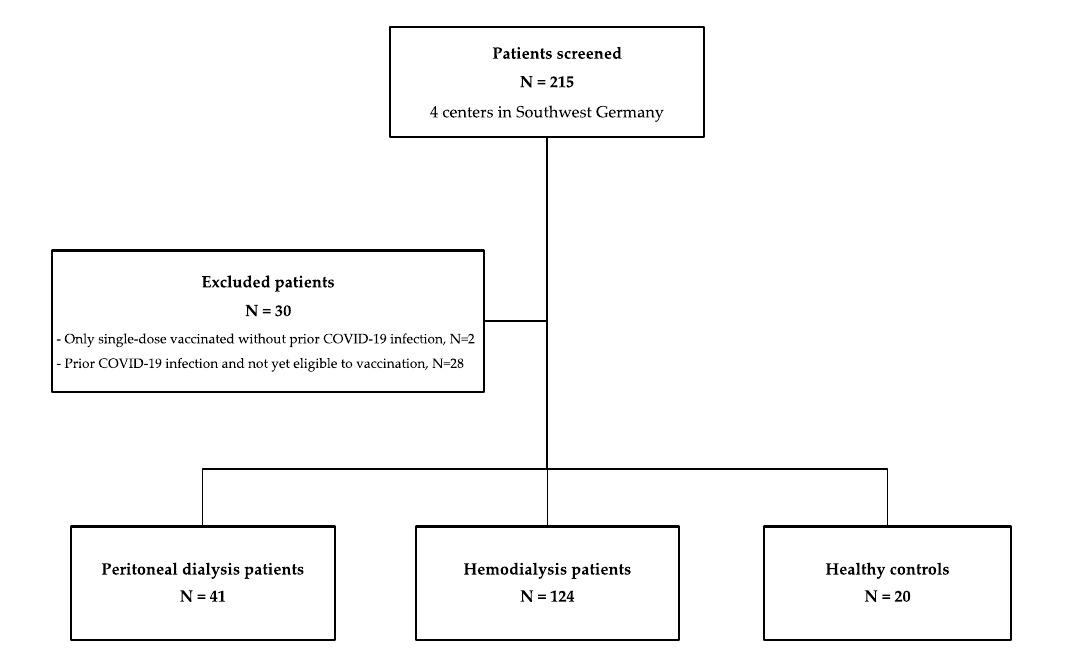
Figure 1. Flow chart of participating individuals. N, number.